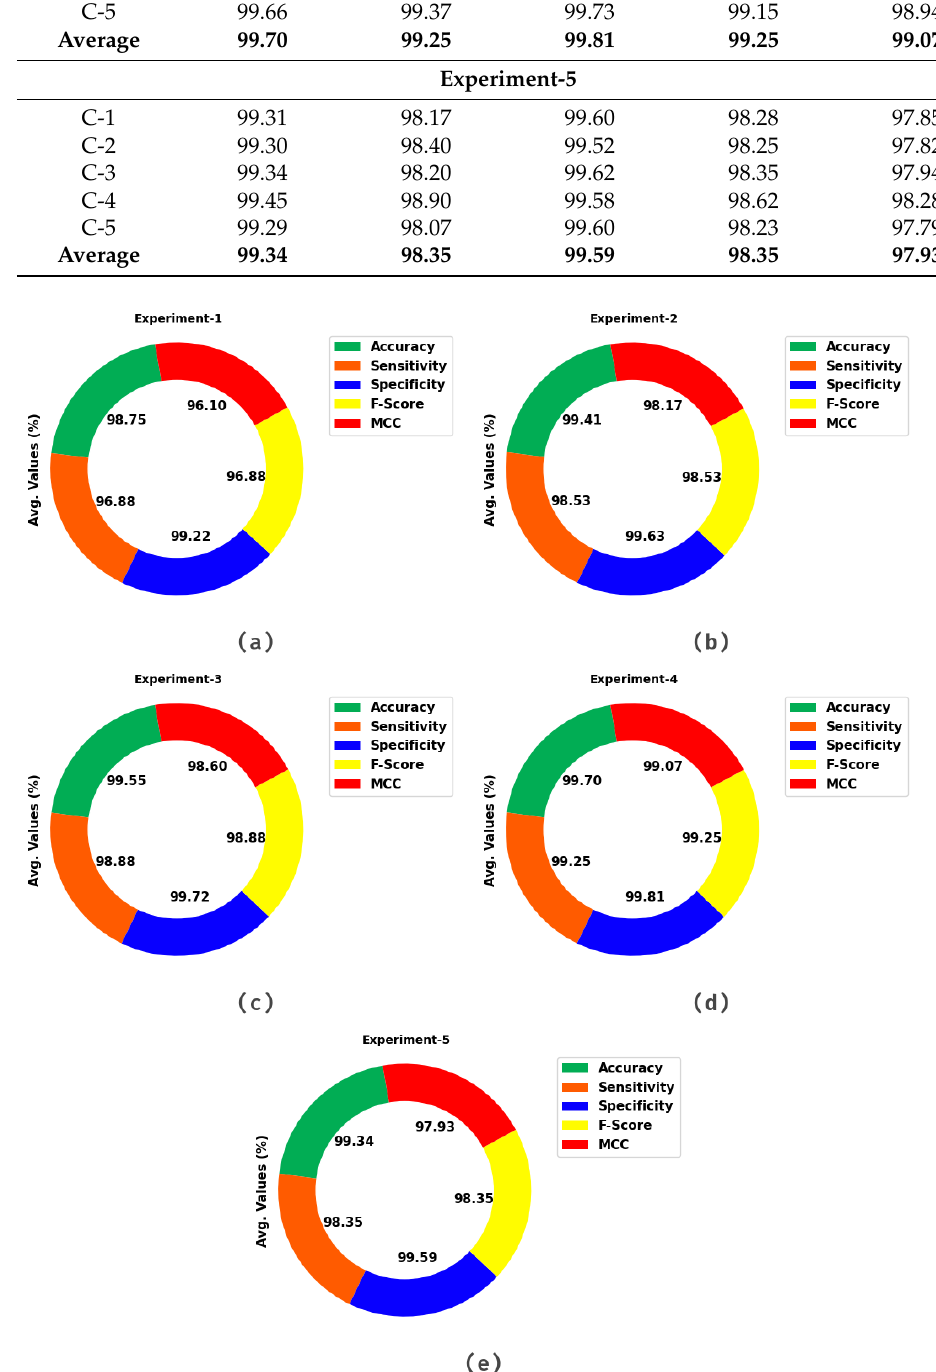
Figure 4. Average analysis of AOEDBC-DL system ( a ) Experiment-1, ( b ) Experiment-2, ( c ) Experiment-3, ( d ) Experiment-4, and ( e ) Experiment-5.